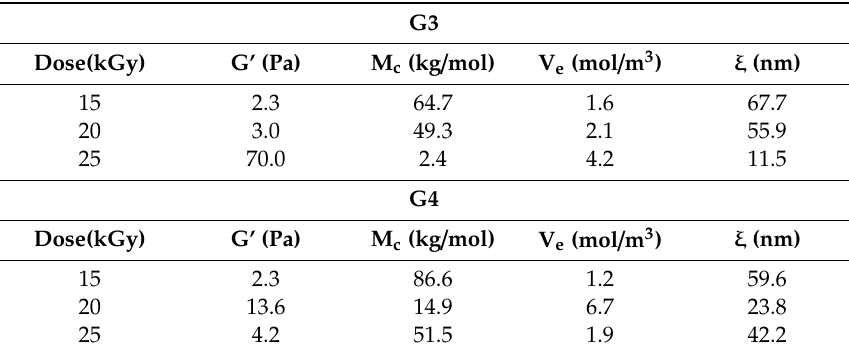
Table 3. Network parameters of the G3 and G4